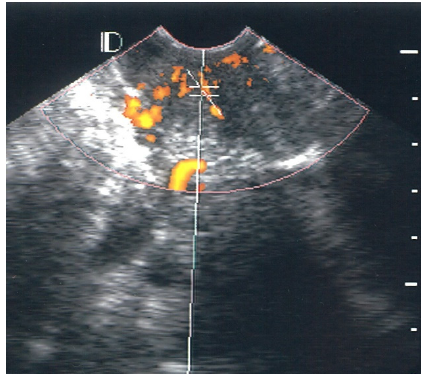
Figure 3. Example of Class III vascularity. There are more than 10 vascular hotspots, and each size ranges from 1 mm to 4 mm. According to the visible vascular classification, 12 cases (12/13, 92.3%) of the subgroup with HPV condyloma were classified as class I, 1 (1/13, 7.7%) as class II, and 0 as class III. In the subgroup with LSIL of the cervix, 18 patients (18/26, 69.2%) were classified as class I, 7 (7/26, 26.9%) as class II, and 1 (1/26, 3.9%) as class III. The vascular classification was significantly higher in the subgroup with HPV cervix infection than in the control group ( p < 0.000). The Fisher exact test with multiple comparison adjustments also revealed significant differences between the HPV condyloma subgroup and control group ( p < 0.000) and the LSIL subgroup and control group ( p < 0.000). However, the difference in the vascular classifications of the HPV condyloma subgroup and LSIL (CIN I) subgroup was insignificant ( p = 0.786). The vascular classification of the cervix correlated negatively with the PI ( − 0.71, p < 0.001), RI ( − 0.63, p < 0.001), VI (S/D)( − 0.58, p < 0.001), and PS ( − 0.24, p = 0.036), but not with the ED (0.065, p = 0.569) or TAMV ( − 0.105, p = 0.357; Spearman’s rho correlation coefficient analysis; Figure 4).